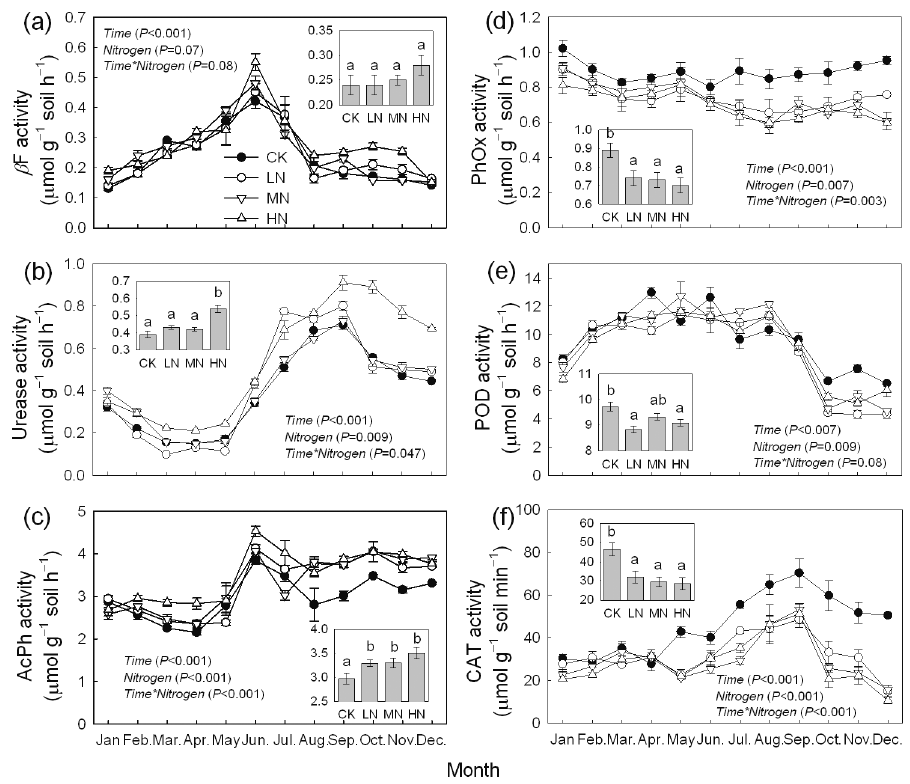
Figure 5. Seasonal variations of soil enzyme activities in a Bambusapervariabilis 6 Dendrocalamopsisdaii plantation from January to December 2009 (mean ± SE, n =3). b F: b -Fructofuranosidase; AcPh: acid phosphatase; PhOx: Phenol oxidase; POD: peroxidase; CAT: catalase. Results of repeated measures ANOVAs are shown in text. Different letters indicate significant difference among N addition treatments when nitrogen effect is significant ( P , 0.05, Fisher’s least significant difference test). CK, LN, MN and HN are as in Fig. 2.